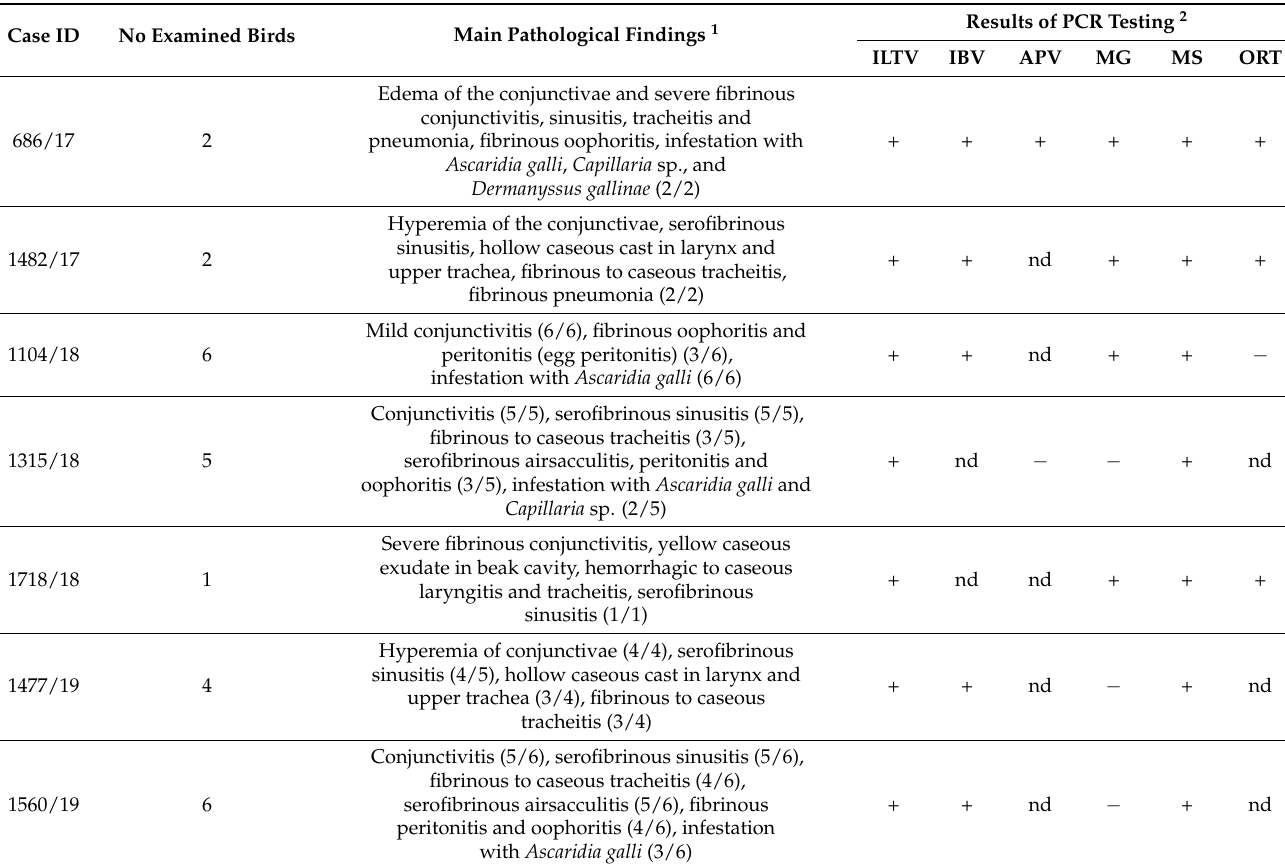
Table 3. Main pathological findings and detection of